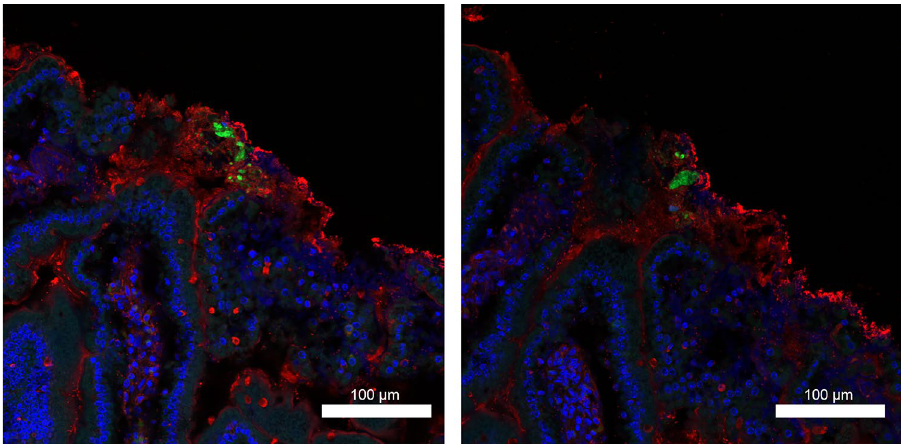
Figure 3. Example cross-sections of a PFA fixed murine small intestine after insonation with QDs and MBs. Images show QDs (green) are lodged in the mucus (stained with WGA, red) after insonation and did not penetrate the underlying intestinal tissue (marked by DNA stain to show nuclei,